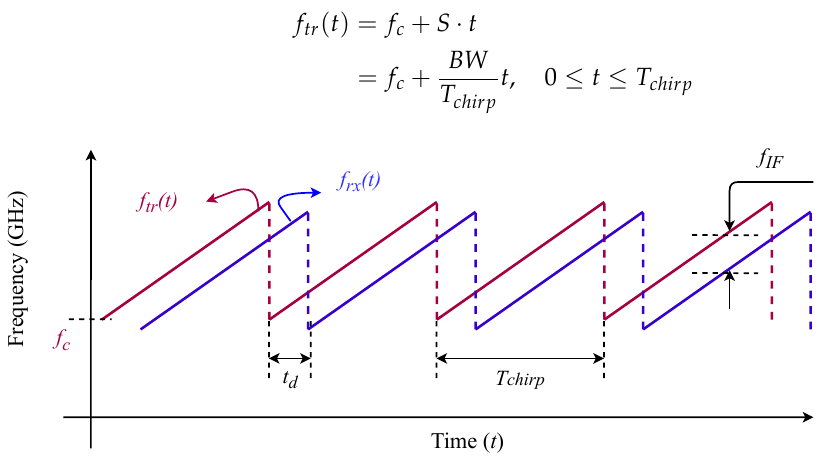
Figure 3. FMCW signal